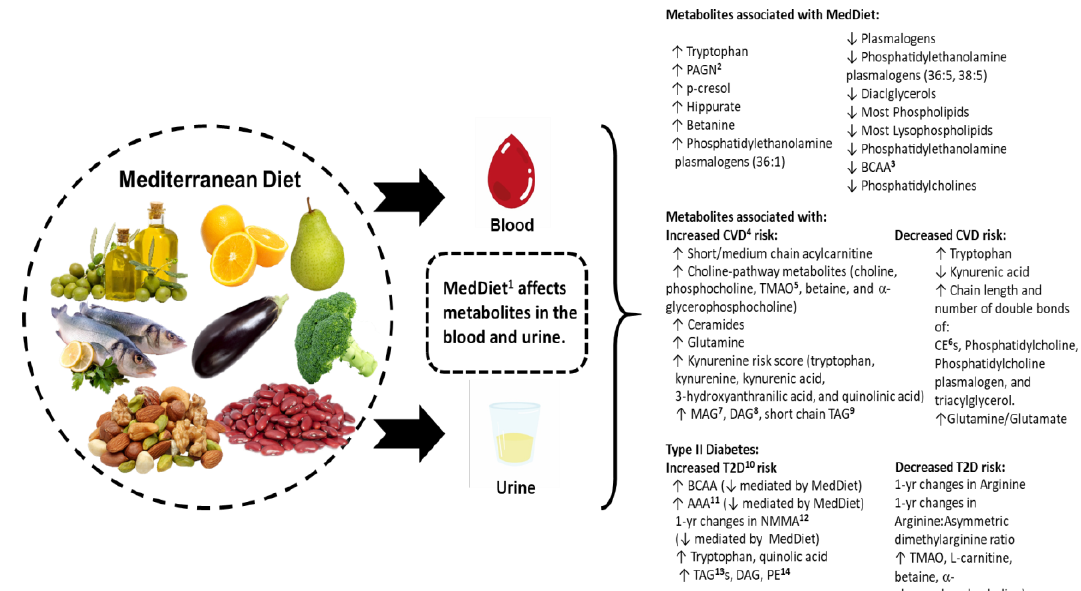
Figure 1. Depiction of the metabolites associated with adherence to the MedDiet in the absence and presence of disease. All the increases in the metabolite profiles are identified with an up arrow, and all the decreases are identified with a down arrow. In general, the results from the PREDIMED study suggest that the MedDiet may counteract the deleterious effect of metabolites related to CVD and diabetes and that it is able to reduce the levels of some of them (e.g., tryptophan and BCAA) after one-year of intervention in comparison with the control group. 1 MedDiet: Mediterranean diet. 2 PAGN: